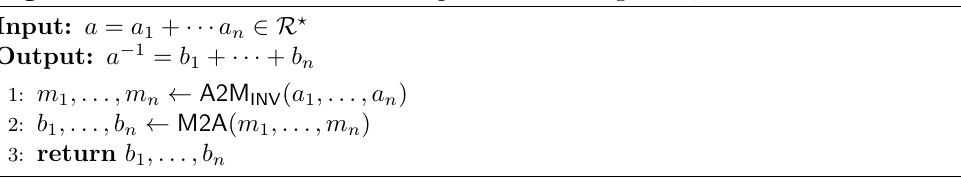
Algorithm 14 Inversion based on multiplicative masking INV Mul